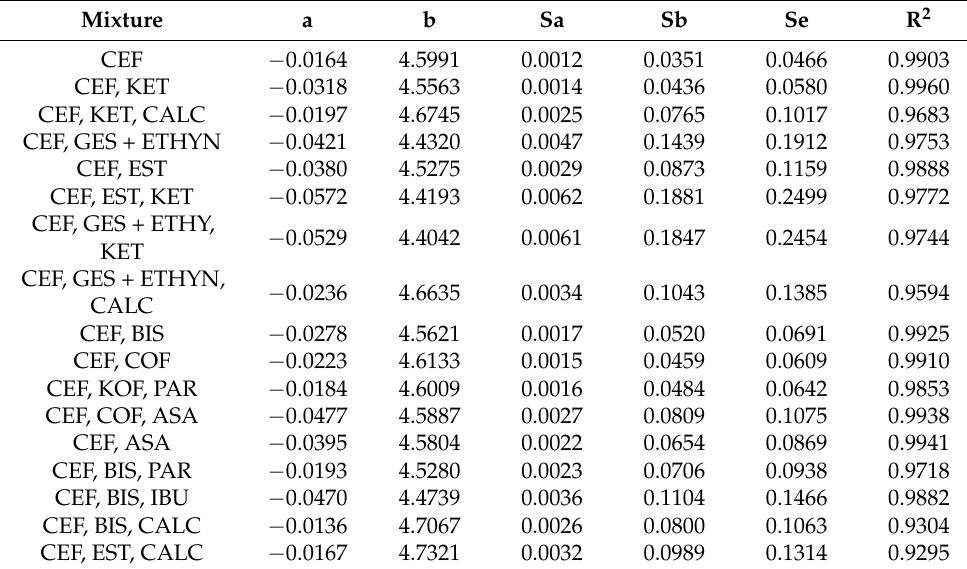
Table 4. Statistical parameters of calibration curves of cefepime in the tested drug mixtures at 4 ◦ C.